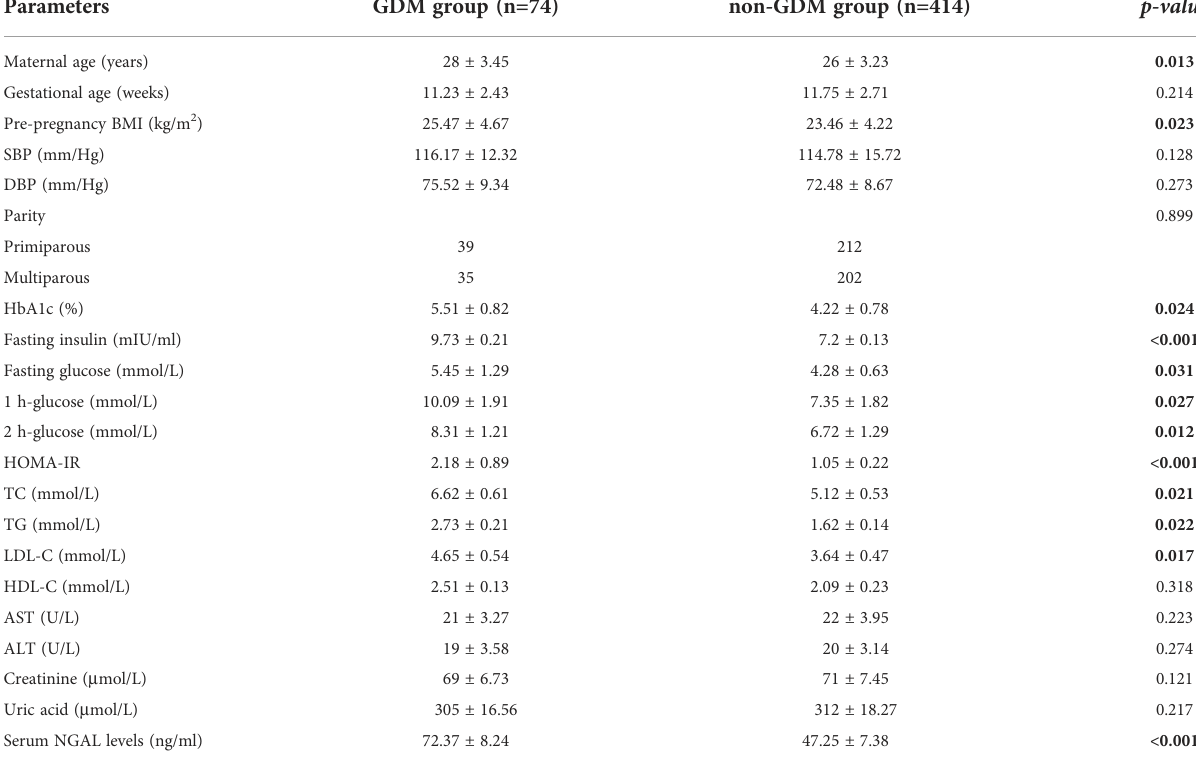
TABLE 1 Clinical and laboratory characteristics of the study